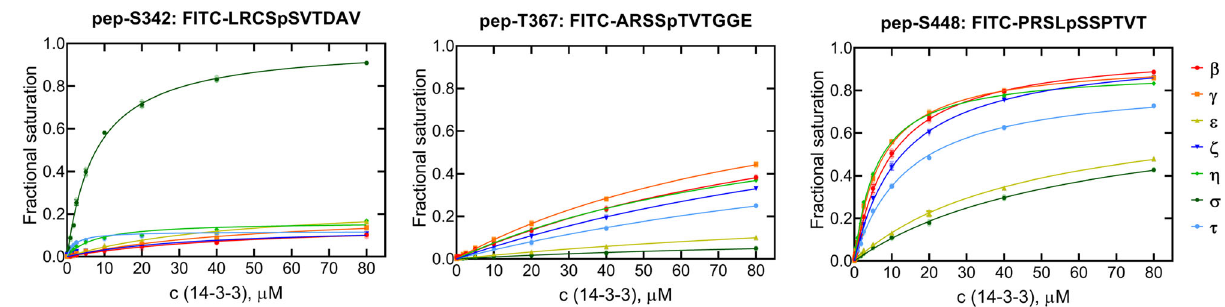
Fig. 4 14-3-3 isoform binding speci fi city of Nedd4-2 phosphomotifs. Binding of FITC-labeled phosphopeptides with 14-3-3 binding motifs of Nedd4-2 (pSer 342 , pThr 367 or pSer 448 ) to all human 14-3-3 isoforms was characterized by FP titrations. The binding af fi nities of these peptides were determined by fi tting FP data to a one-site binding model. The corresponding sequences of these peptides are shown at the top. Background polarization was subtracted from all values. Results are expressed as mean ± SD ( n = 3). Error bars are not visible if they are smaller than the size of the symbol. Table 1 14-3-3 isoform binding speci fi city of individual 14-3- 3 binding motifs of